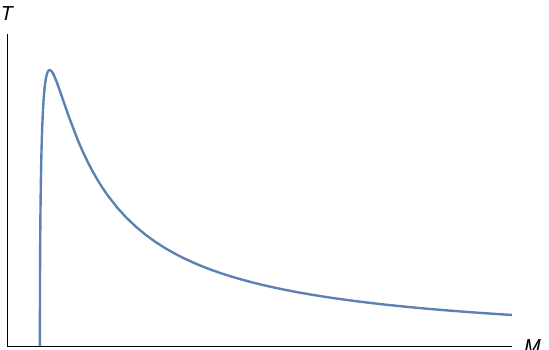
Figure 3 . Qualitative plot of the Hawking temperature as a function of the